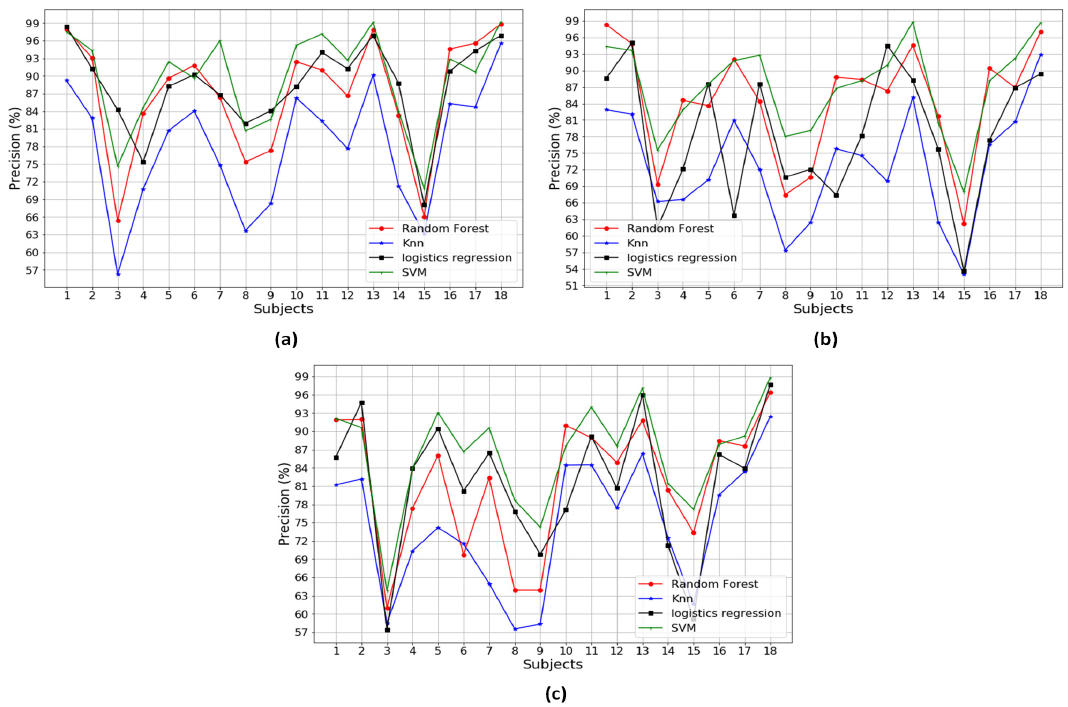
Figure A3. The average precision performance over a combination of two types of sensors: ( a ) precision over Pre+Acc; ( b ) precision over Pre+Gyro; and ( c ) precision over Acc+Gyro.